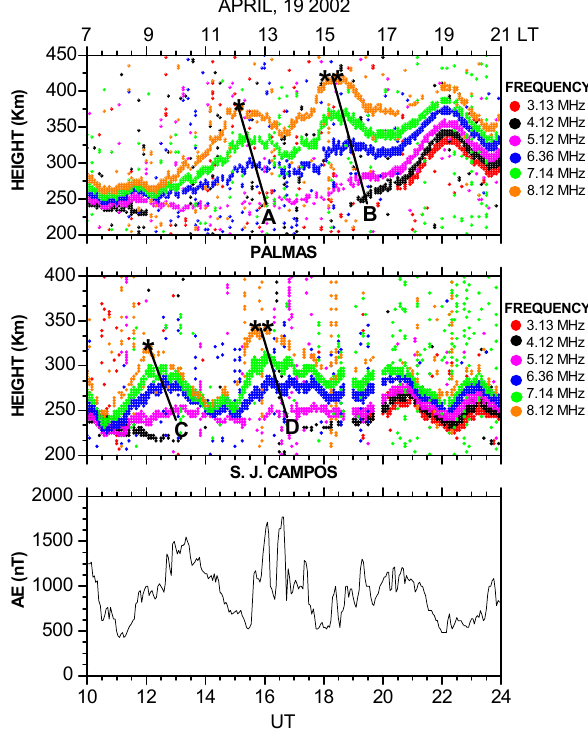
Fig. 6. The virtual height variations for fixed frequencies ob- served on 19 April 2002, during the period 10:00–24:00UT (07:00– 21:00 LT), observed at PAL (top) and SJC (bottom). The transver- sal lines and the positions marked with asterisks have been used to calculate the vertical phase propagation and horizontal velocities,